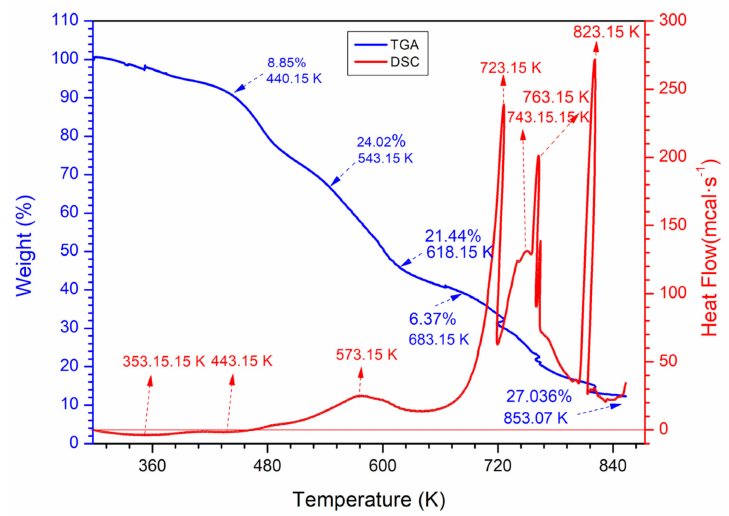
Figure 2. Thermal analysis of guava fruit ( Psidium guajava L.)